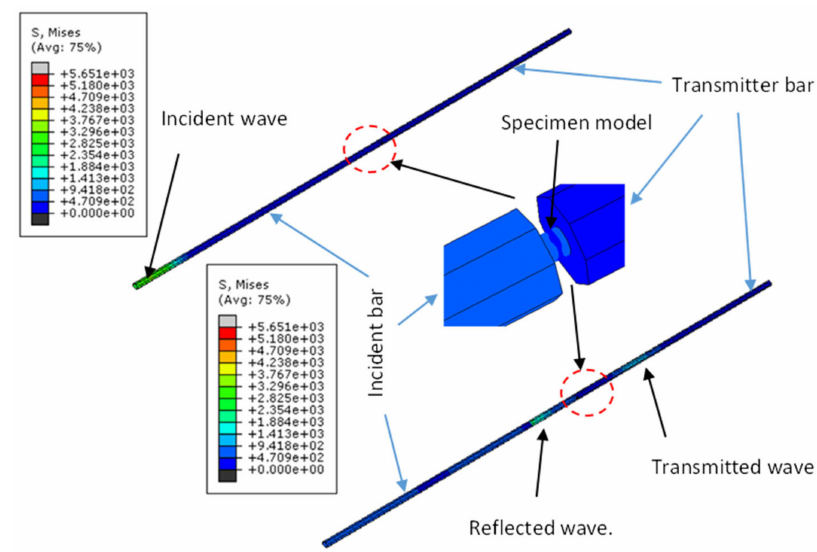
Figure 4. Numerical simulation of a compressive wave in a SHPB